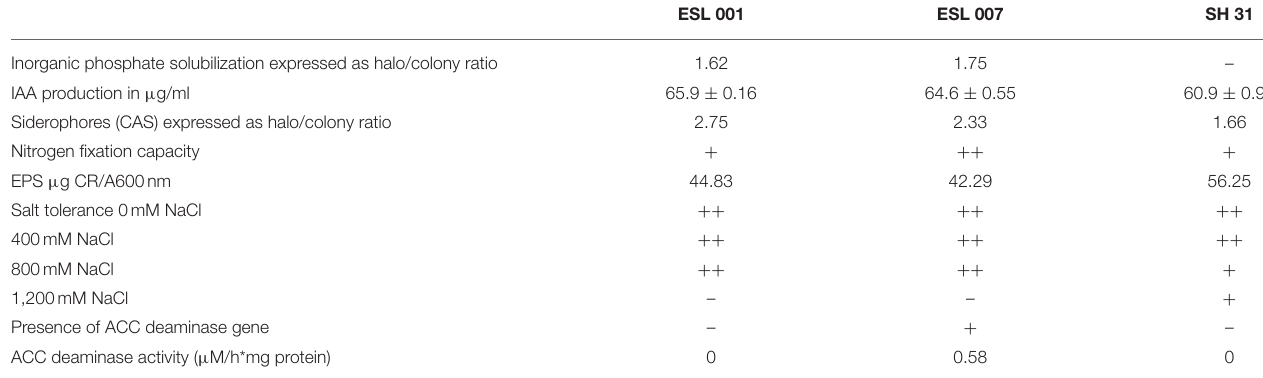
TABLE 3 | Characterization of the three selected